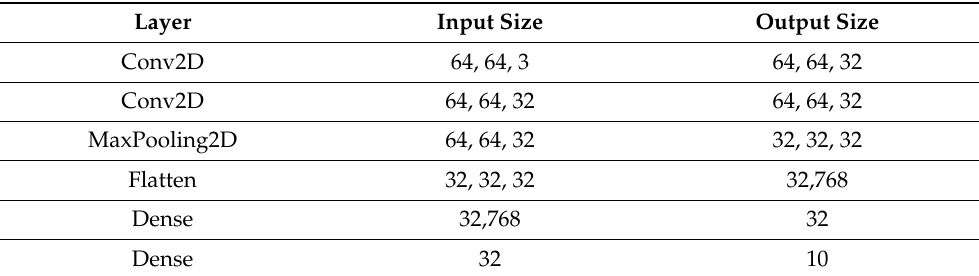
Table 2. The parameters of CNN model.